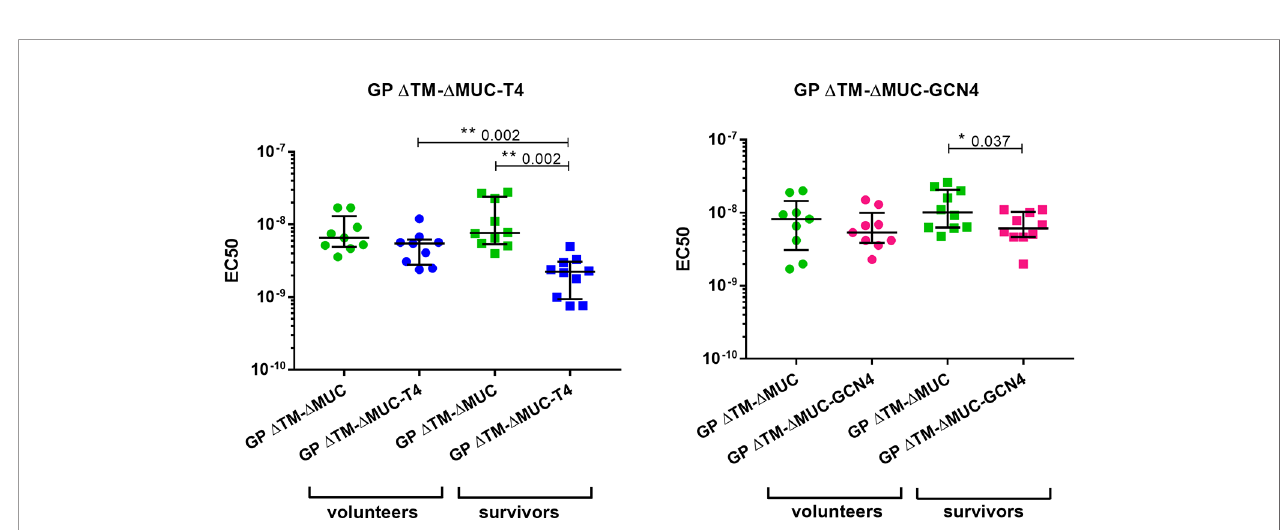
FIGURE 7 | The T4 trimer shows the highest apparent af fi nity (lowest EC50) for sera of clinical trial volunteers and Ebola disease survivors. A panel of 10 sera obtained from clinical trial volunteers (dots) and a panel of 10 Ebola virus survivors (squares) were analyzed in a competition ELISA to test their respective af fi nities for the monomer GP D TM- D MUC (green) or for the GP D TM- D MUC-T4 (blue) or – GCN4 (pink) trimers. Median values with inter-quartile range values are represented. Statistical signi fi cance among groups was evaluated by means of the Wilcoxon test (among the same group of individuals) and the Mann-Whitney test (comparison of volunteers vs.